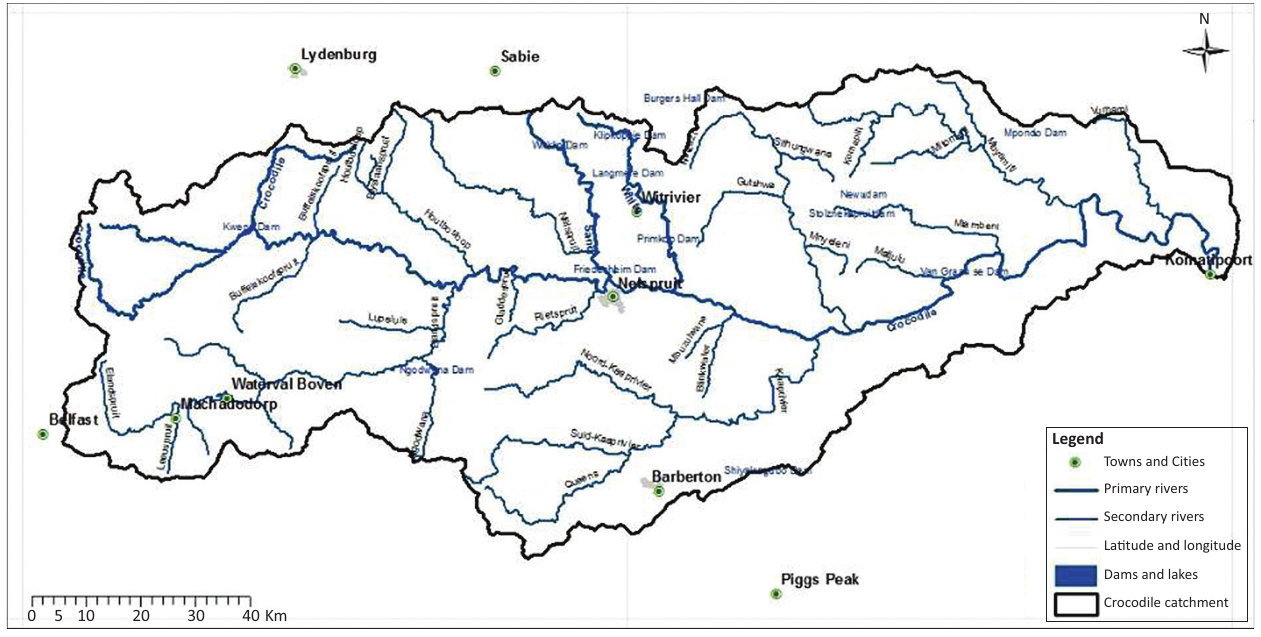
FIGURE 2: The Crocodile River catchment showing Nelspruit and its